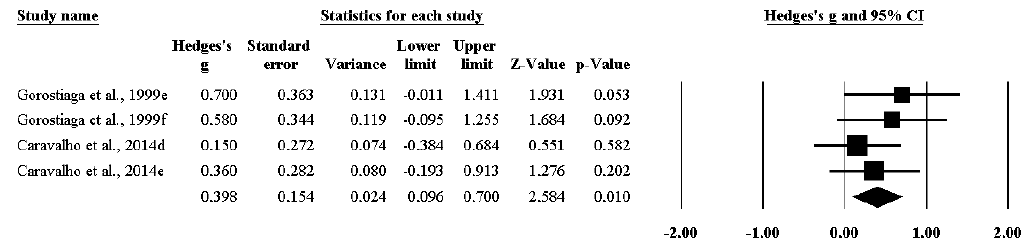
Figure 3. The impact of resistance training on throwing among handball players.